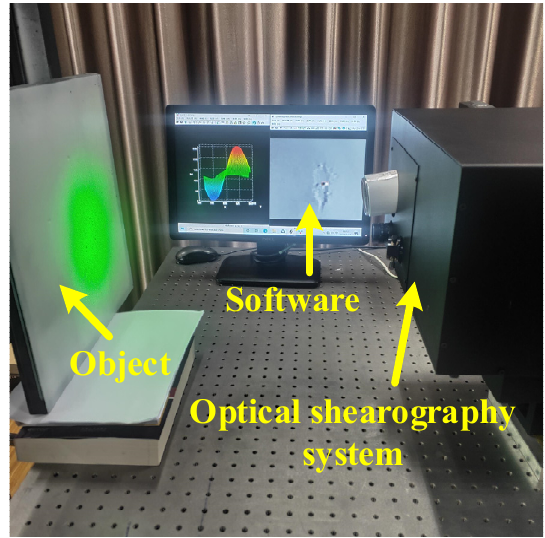
Figure 8. Shearography setup.